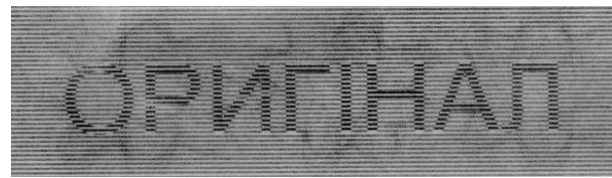
Figure 9. Indicators of forgery, strong moire.